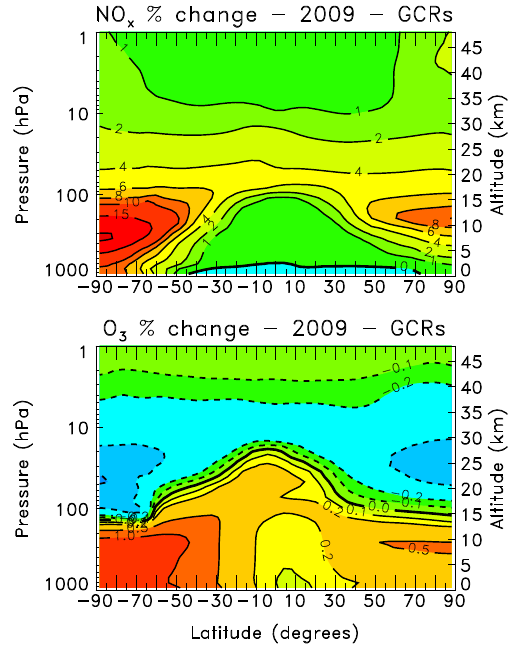
Figure 4. Annual average percentage change for year 2009 in zonal mean NO x (top) and ozone (bottom) due to GCRs in the SD- WACCM (simulation Base_SD_W compared to GCR_SD_W ). The contour intervals for the NO x changes are 0, 1, 2, 4, 6, 8, 10, and 15%. The contour intervals for the ozone changes are − 1, − 0 . 5, − 0 . 2, − 0 . 1, 0, 0.1, 0.2, 0.5, 1, and 2%.